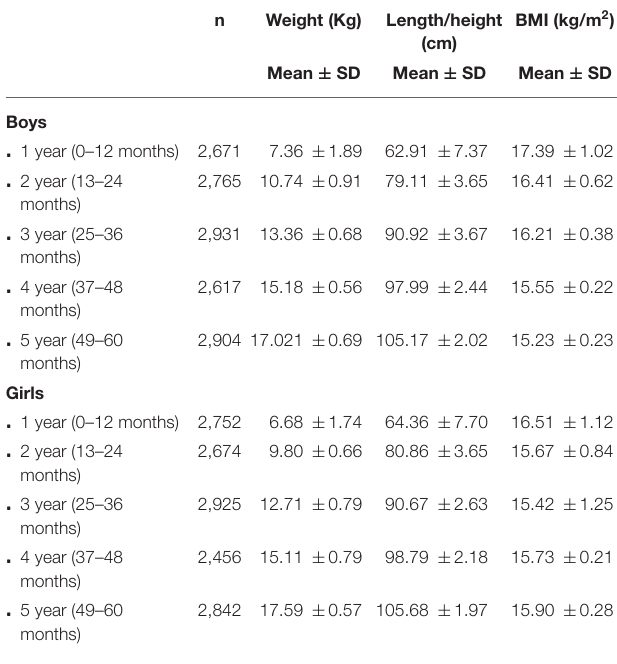
TABLE 1 | Mean and standard deviation (SD) for weight, Length/Height, and BMI of children aged from birth up to 5 years. n Weight (Kg) Length/height